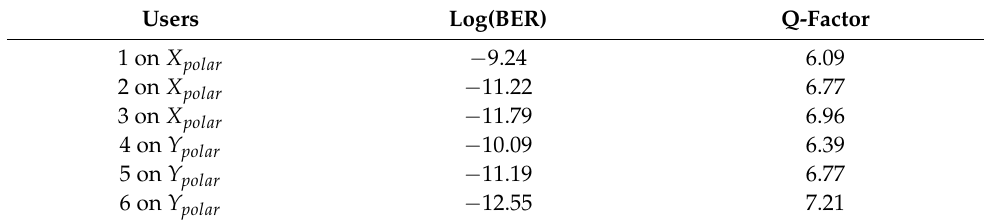
Table 5. Performance results for clear weather conditions.